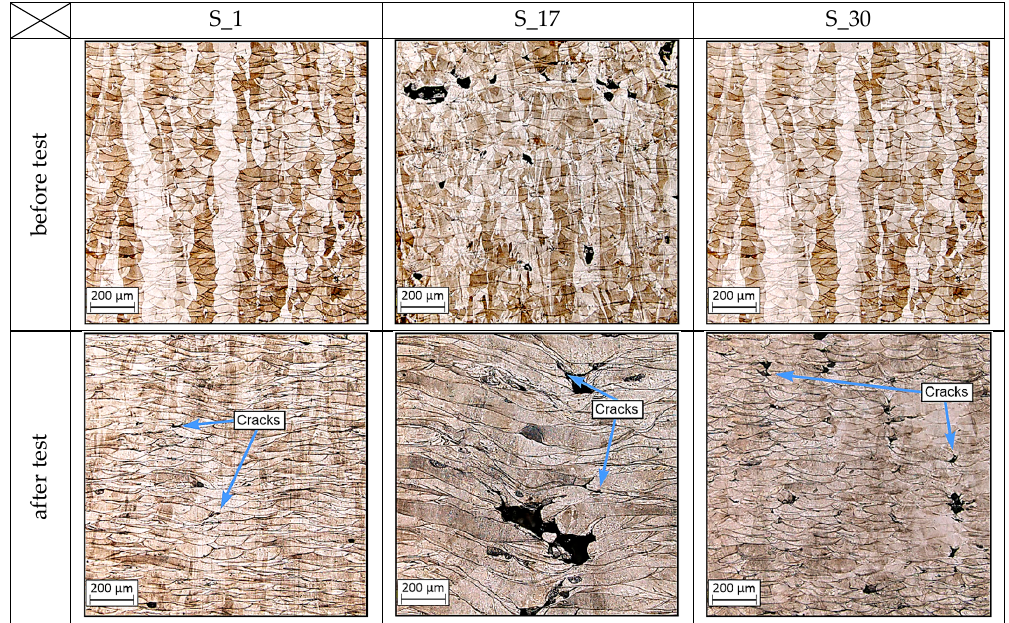
Figure 19. Microstructures of the samples before and after the Split–Hopkinson tests.